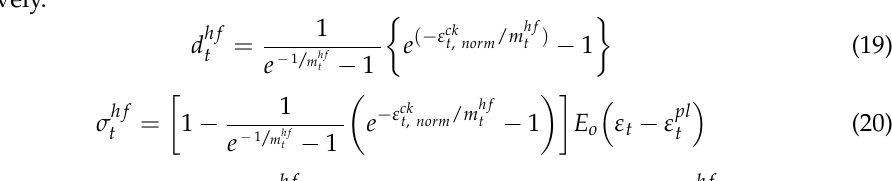
( b ) Figure 8. Effect of calibration on the behavior of the control sample ( a ) viscosity parameter ( b ) mesh size.